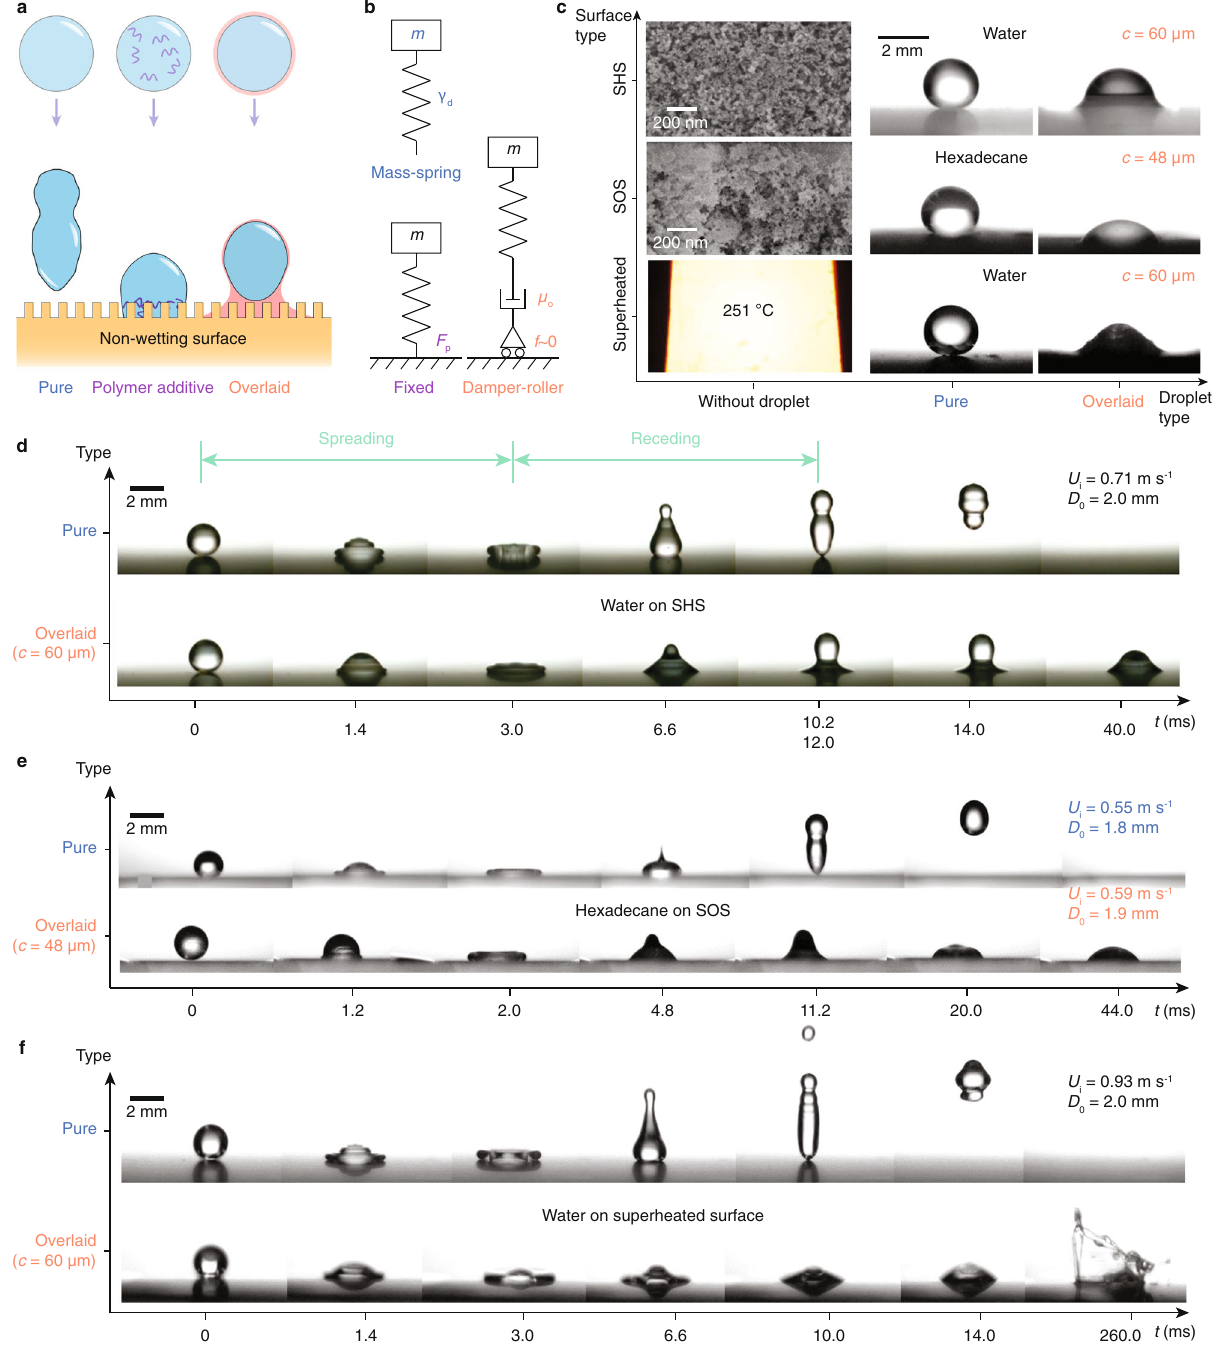
Fig. 1 Enhanced deposition. a Schematics showing the liquid overlayer and conventional polymer additives in breaking the super-repellency. b Schematics showing the mechanical analogies of the systems in ( a ). Pure water behaves like a fl oating mass spring because of the surface tension γ d ; the polymer additives pin the droplet, offering a fi xed support, and the overlayer dissipates the kinetic energy (damper) and enables in-plane mobility (roller support). c Scanning electron microscopy (SEM) images showing nanotextures of the modelled superhydrophobic surface (SHS) and superomniphobic surface (SOS), and an infrared thermal image showing the superheated surface above the Leidonfrost temperature of water (left column). Microscopy images showing the high water contact angles on the superhydrophobic/superheated surface and the high hexadecane contact angle on the superomniphobic surface (middle column). Microscopy images showing the static states of overlaid droplets on the modelled super-repellent surfaces (right column). Silicone oil (20 mPa s) and lubricant oil (Krytox VPF1506) are chosen as overlayers for water and hexadecane, respectively. Sequential images showing the dynamic impacts of ( d ) water droplets on the superhydrophobic surface (We pure = 14.0, We overlaid = 25.2), e hexadecane droplets on the superomniphobic surface (We pure = 15.5, We overlaid = 72.0) and f water droplets on the superheated surface (We pure = 24.2, We overlaid =